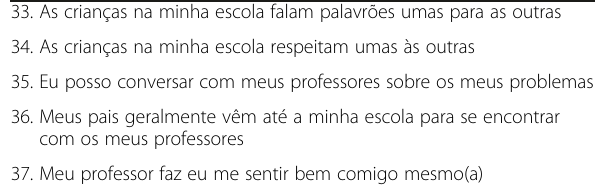
Table 3 Brazilian Portuguese items of the School Climate Survey – Revised, Elementary and Middle School Version (SCS-MS)